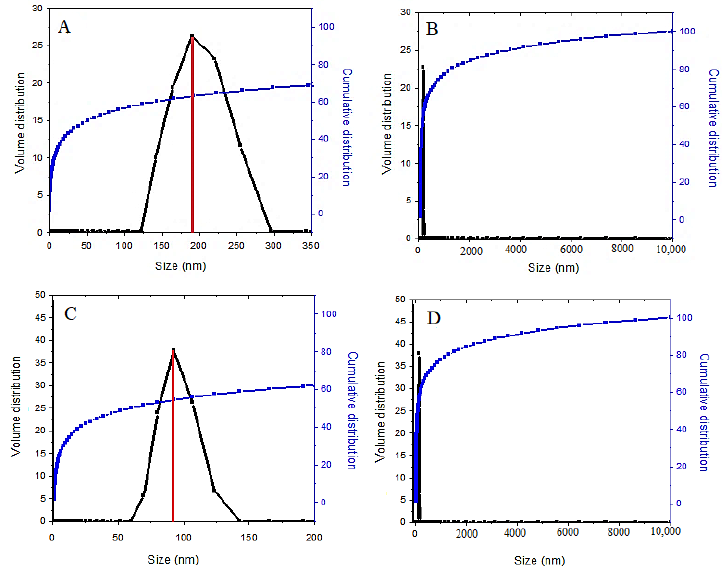
Figure 7. The relative ( A ) and cumulative ( B ) particle size distribution of superparamagnetic iron oxide nanoparticles; the relative ( C ) and cumulative ( D ) particle size distribution of drug-loaded magnetic nanoparticles (M-PEG–SO–ZLDH) .